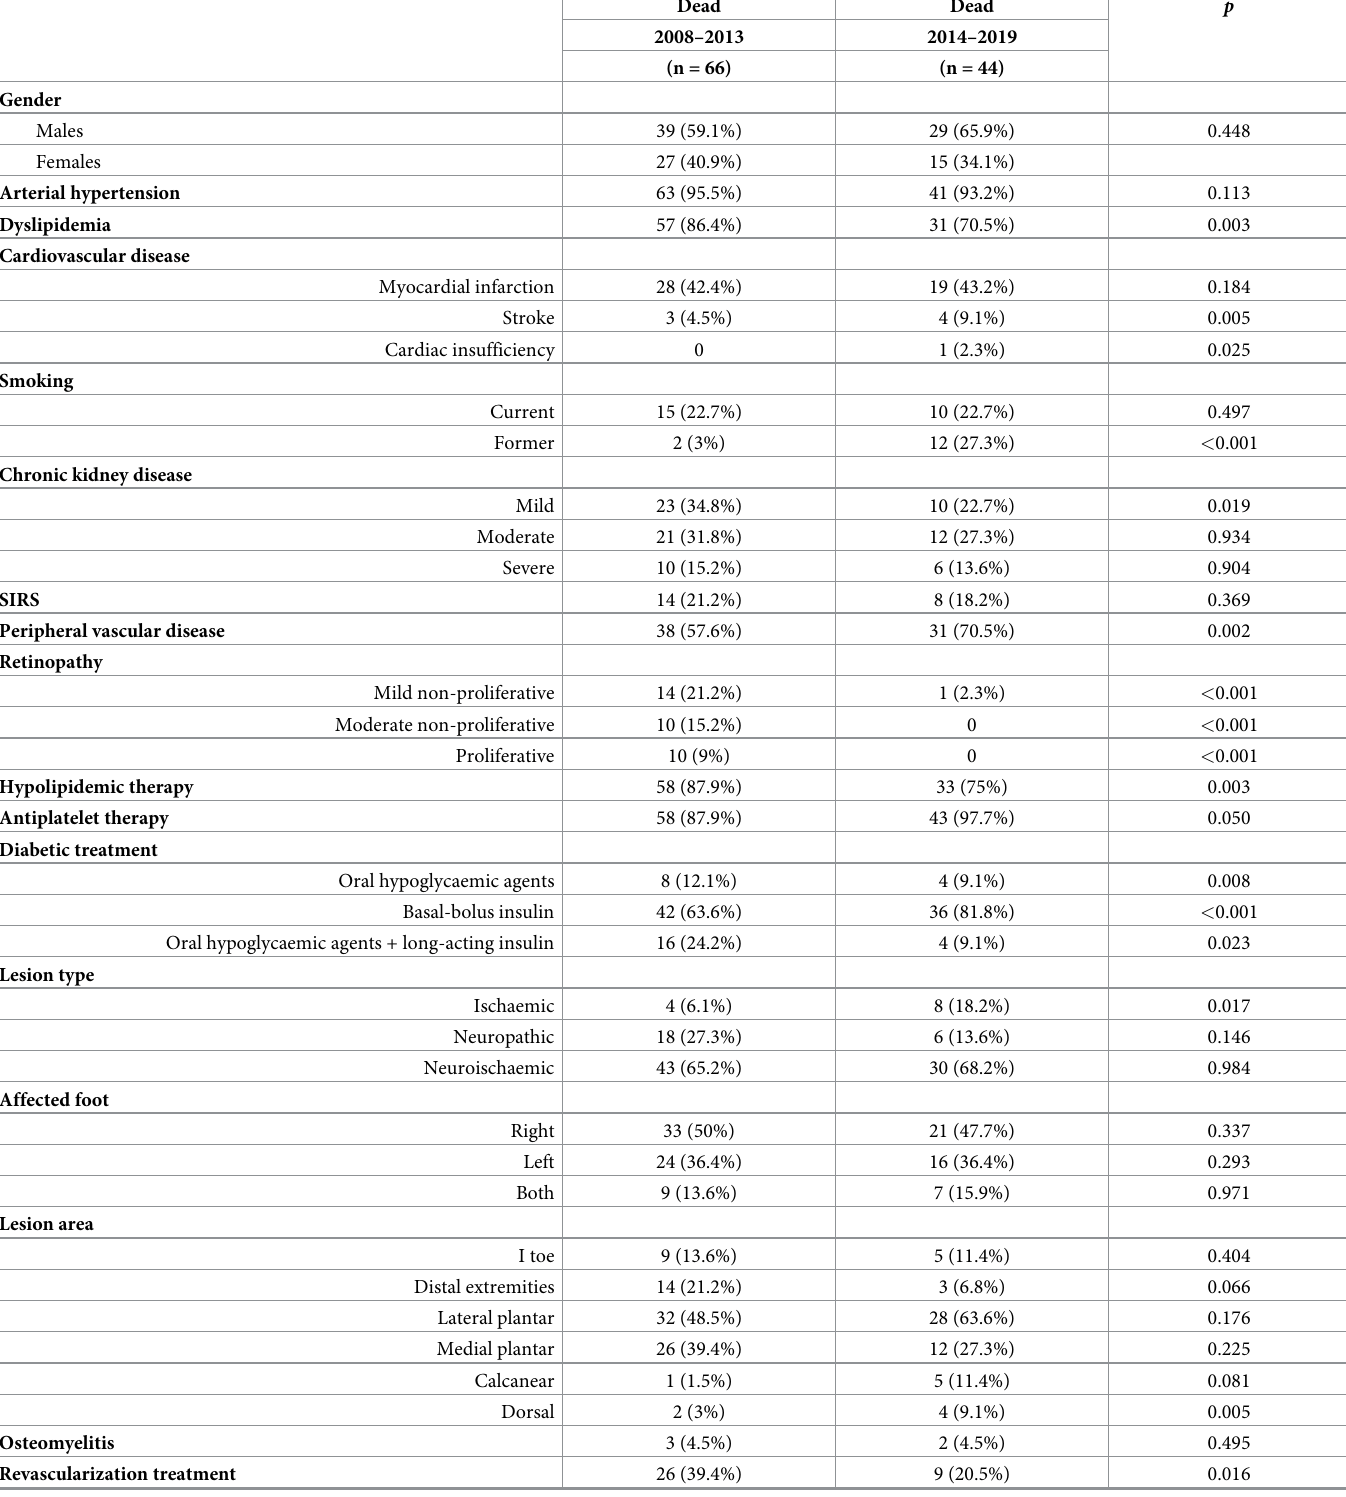
Table 4. General characteristics of dead patients with diabetic foot complication divided in the two periods of